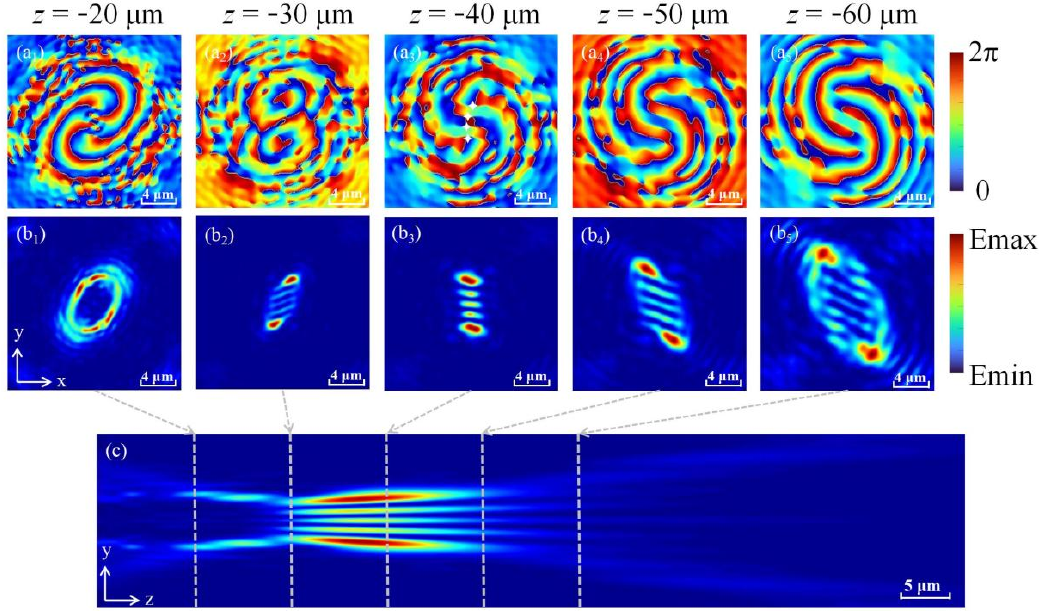
Figure 4. Schematic diagram of beam propagation with LOCP. The phase distribution ( a ) and the light field ( b ) diagrams of the XOY plane from z = − 20 μ m to z = − 60 μ m. ( c ) The optical field distribution diagram of the LOCP beam in the YOZ plane.